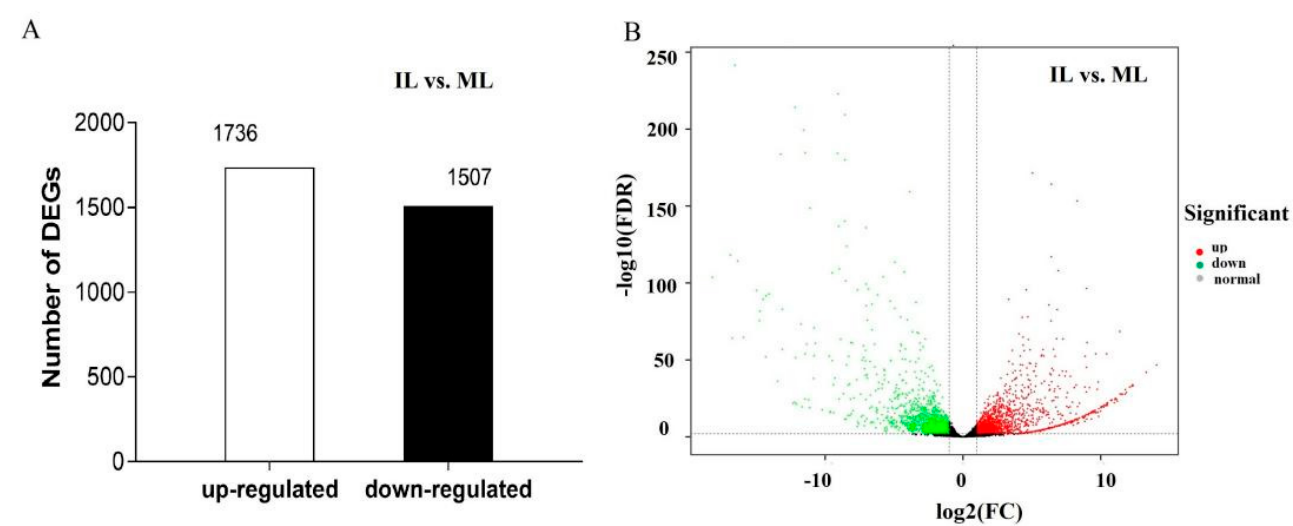
Figure 9. ( A ). The histograms of DEGs in groups; the number of DEGs is shown on the top of histograms. ( B ). The volcano map of DEGs in IL vs. ML; each point represents the differentially expressed gene and the abscissa represents the logarithm of the expression multiple of a gene in the two groups. Green and red dots represent genes with significant expression differences, green represents downregulation of gene expression in ML compared to IL, red represents upregulation of gene expression in ML compared to IL, and black dots represent genes with no significant expression differences. IL represents the one − year post − infection larva of H . xiaojinensis by O. sinensis . ML represents the mummified larva of H . xiaojinensis.